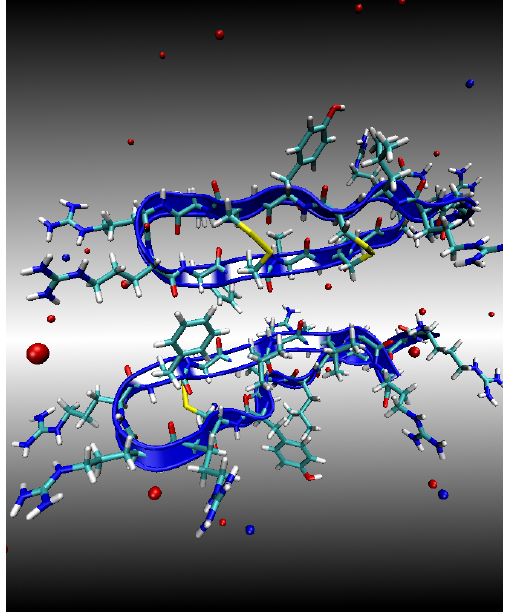
Structure of the PG1 dimer in the parallel β -sheet arrangement, in an NCCN packing mode. The peptide backbones are shown as yellow ribbons. The solution Na + and Cl − counterions are shown as red and blue spheres, respectively. The peptide residues Arg and Cys are also shown as sticks. Water molecules have been removed for